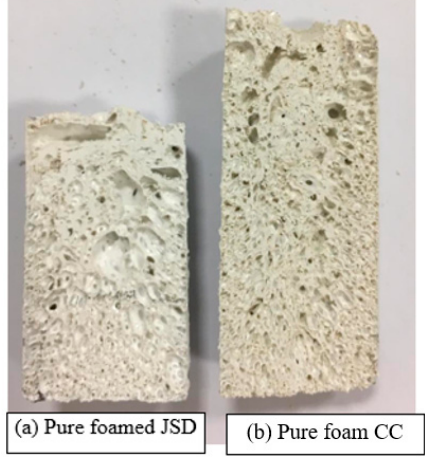
Figure 11. Foamed Samples.